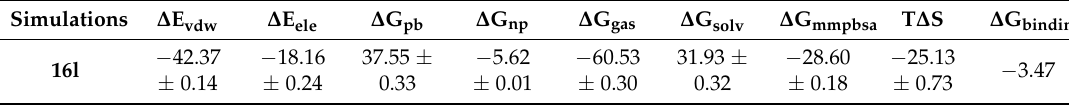
Table 3. Binding free energies (Kcal/mol) of compound 16l in mt -DHFR.